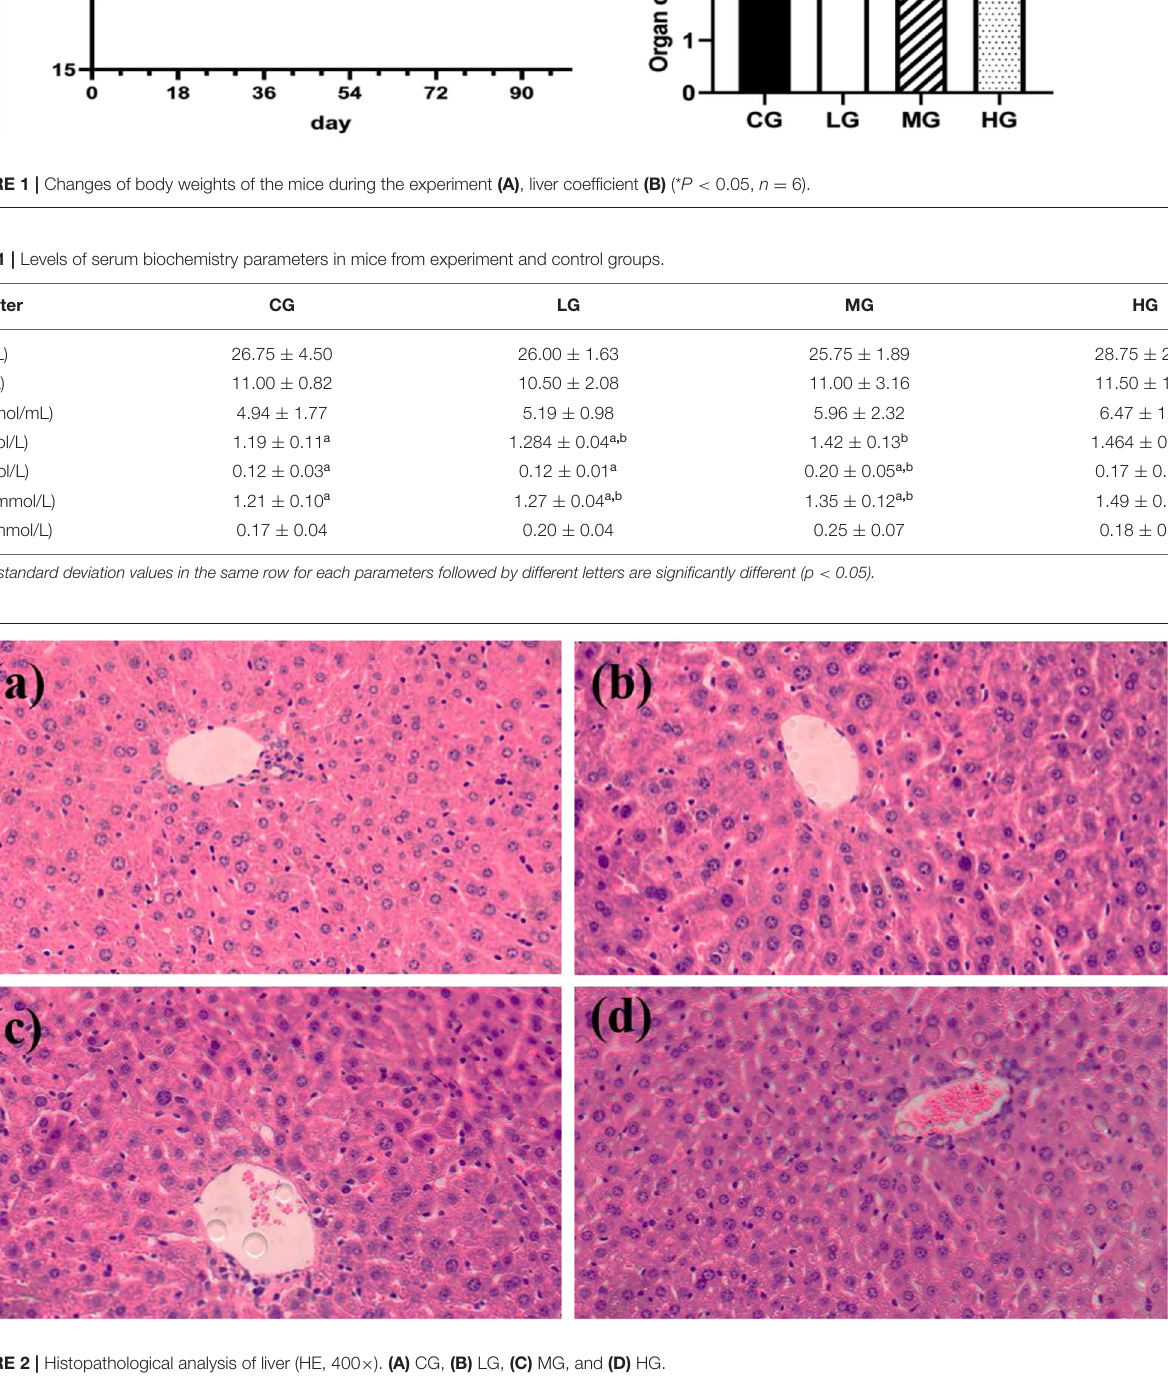
Frontiers in Nutrition |